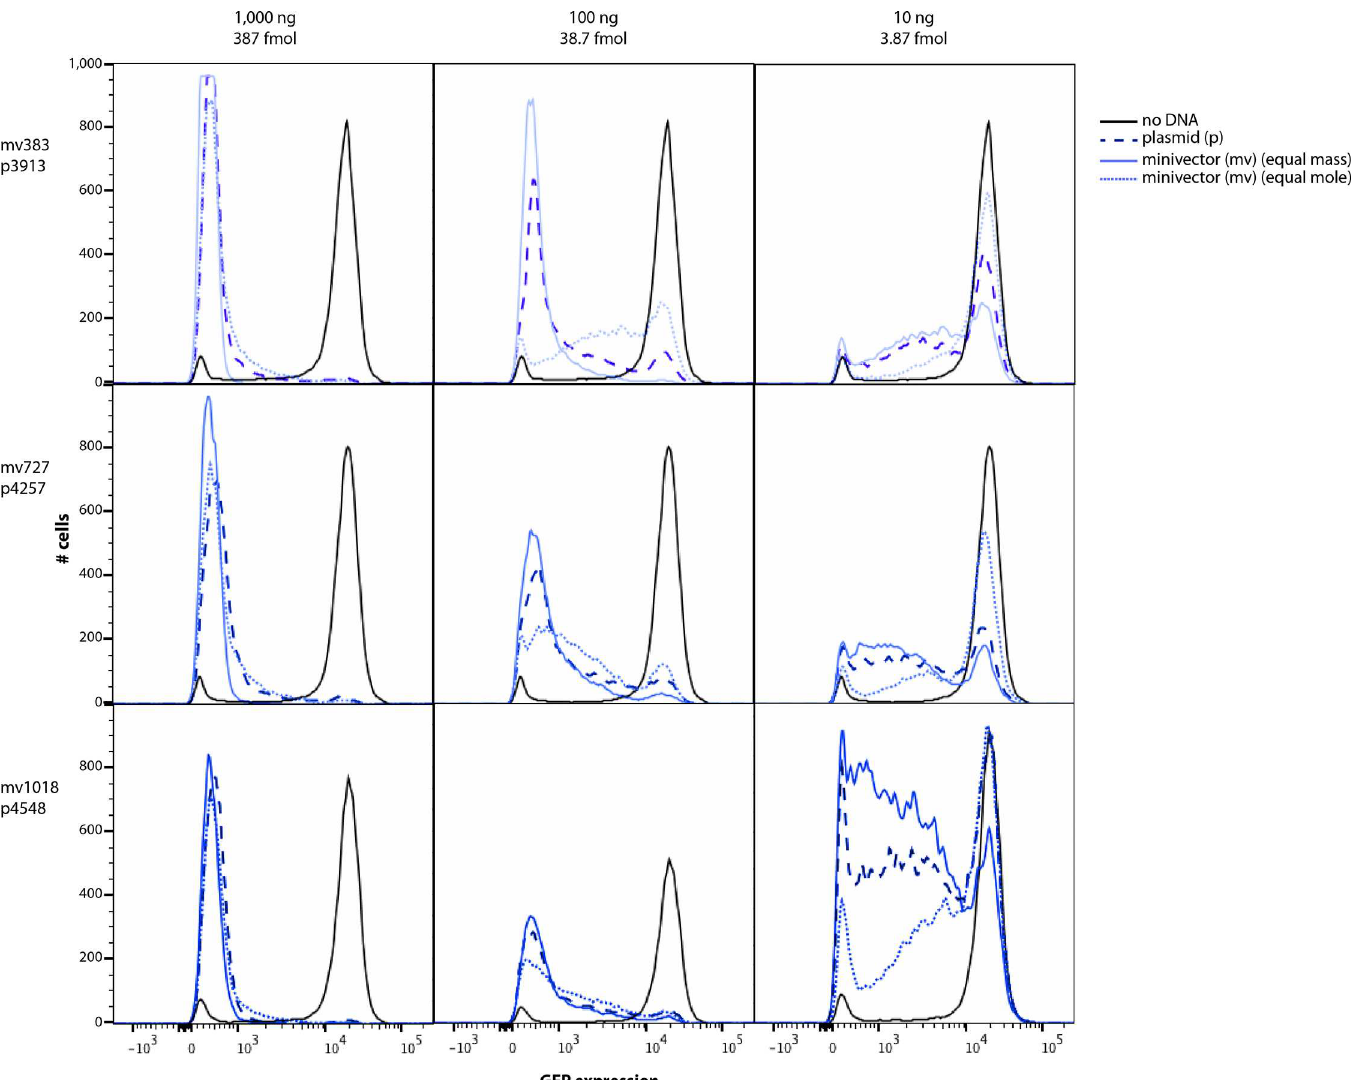
Fig 6. Direct comparison of transfection efficiency for three pairs of vectors. The larger vectors (dasheddark blue lines) were each transfected at one of three concentrations (mass and moles for these vectors are given) into 90,000HeLa-GFP cells. For each concentration of the larger vector, each smaller vector was separatelytransfected into HeLa-GFP cells at two different concentrations. One concentration of the smaller vector was equivalent to an equal mass of minivector (solid light blue line), and the other concentration was equivalentto an equal number of moleculesof smaller vector (dotted light blueline). Cells were analyzedusing flow cytometry 48 hours post-transfection. Each panel is a representative result of an experiment that was performed at least twice in